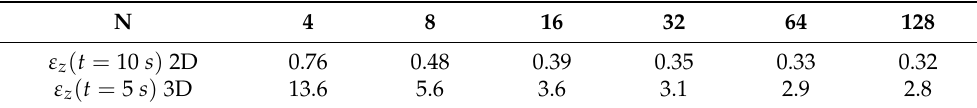
Table 4. Convergence of the percentage error of the z-position ε z ( t ) (%) of the central point for different numbers of grid